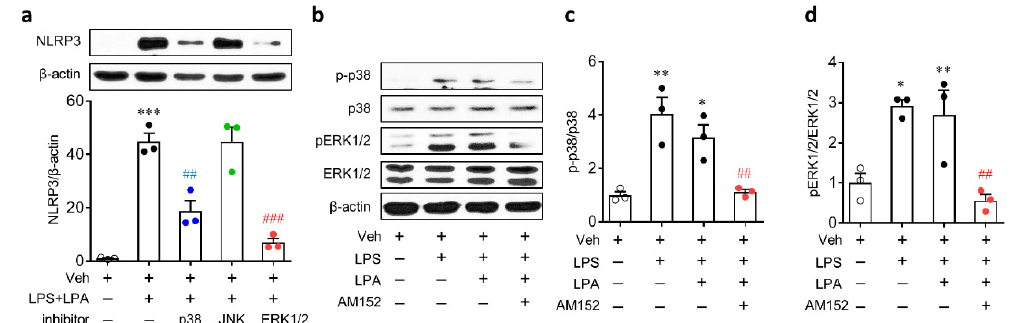
Figure 8. Activation of extracellular signal-regulated kinase 1/2 (ERK1/2) and p38 mitogen-activated protein kinase (MAPK) is involved in LPA 1 -mediated NLRP3 upregulation in LPS-primed BMDMs, followed by LPA exposure. Cells were primed with LPS (500 ng/mL) for 4 h, followed by an exposure to LPA (1 µM) for 1 h. Protein expression levels of NLRP3 and phosphorylation of p38 and ERK1/2 were determined by Western blots. ( a ) Effects of MAPK inhibitors on NLRP3 upregulation in LPS- primed BMDMs based on Western blot analysis. Representative blots and quantification data are